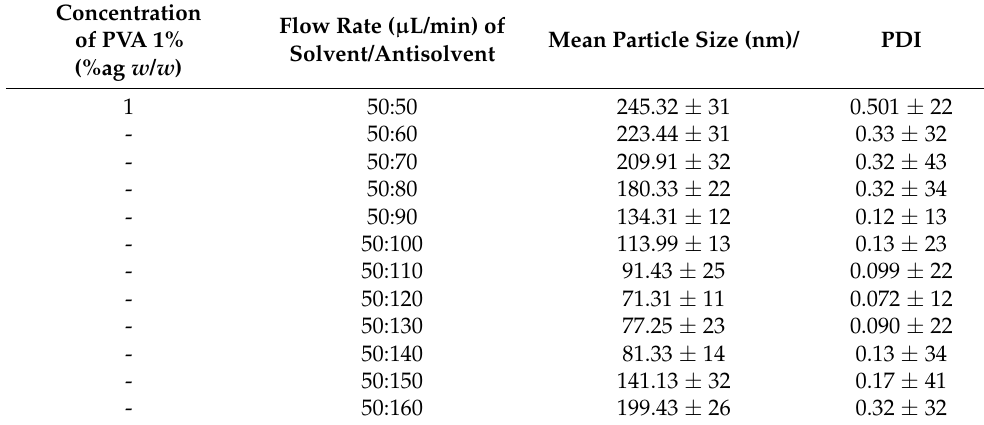
Table 2. Optimization and Effect Flow rate on P.S/PDI of